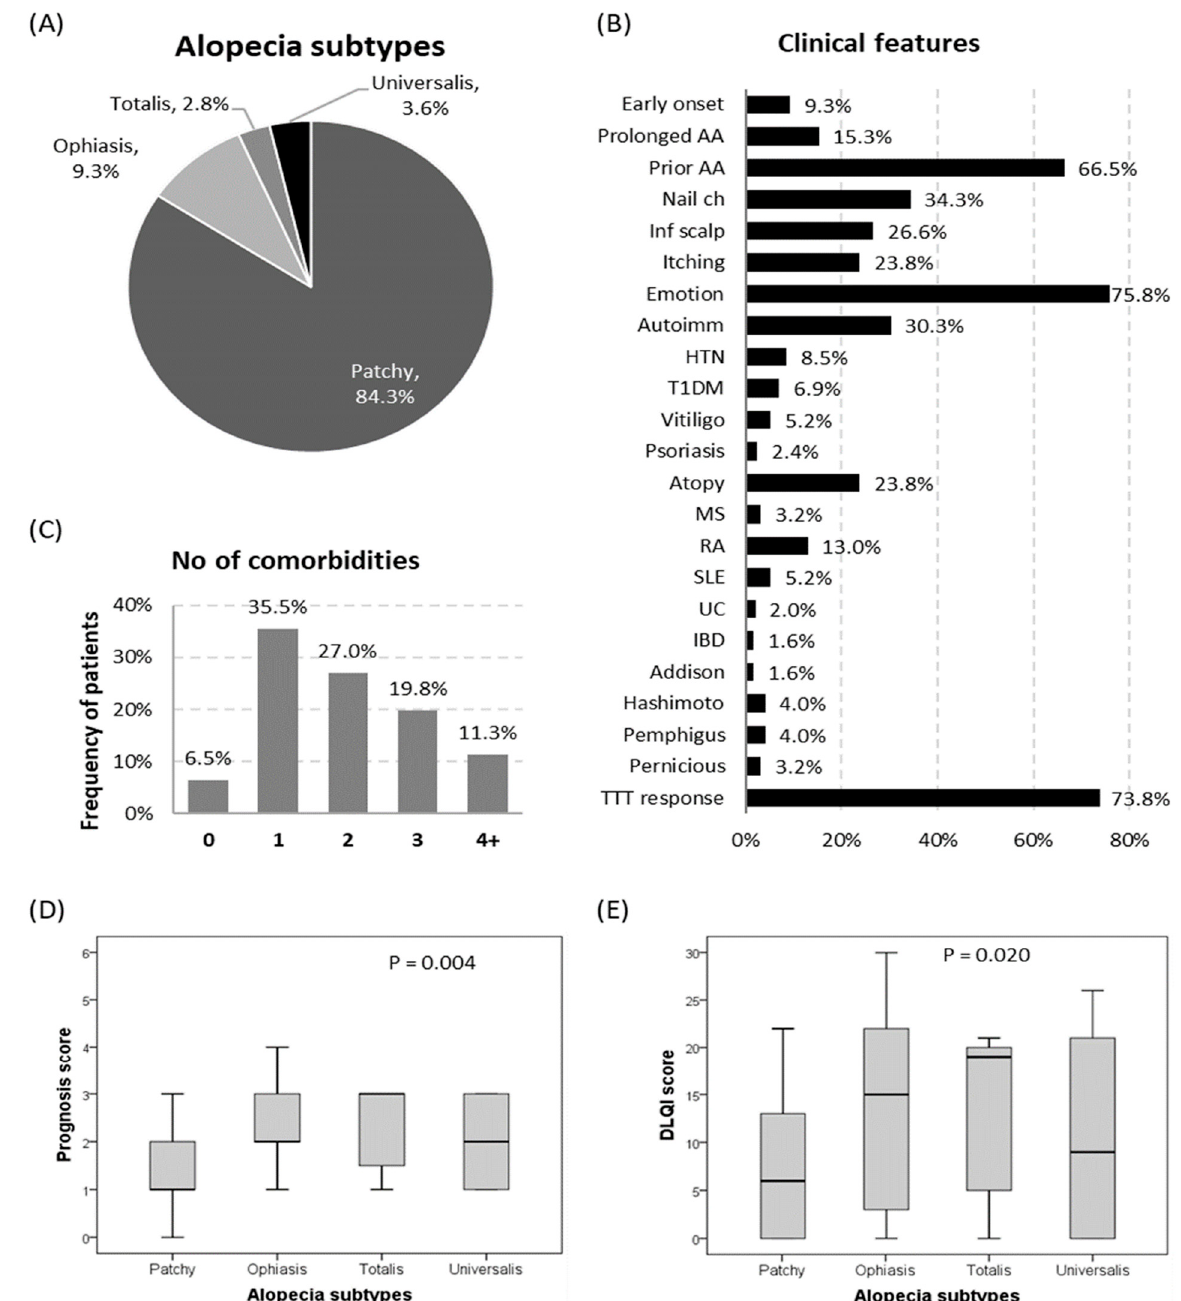
Figure 2. Disease characteristics of the alopecia cohorts. ( A ) Alopecia subtypes. ( B ) Clinical features of patients with AA. ( C ) Frequency of AA patients with different disease comorbidities. ( D ) Prog- nosis score among different alopecia clinical subtypes. ( E ) Dermatology Life Quality Index score among different alopecia clinical subtypes. The Kruskal–Wallis test was used. p -values < 0.05 were considered statistically significant. AA: alopecia areata or other autoimmune disorders; nail ch: nail changes; Inf scalp: scalp infection; HTN: hypertension; T1DM: type 1 diabetes mellitus; MS: multiple sclerosis; RA: rheumatoid arthritis; SLE: systemic lupus erythematosus; UC: ulcerative colitis; IBD: inflammatory bowel disease; emotion: emotional or psychological problem; TTT: treatment; and DLQI: Dermatology Life Quality Index.